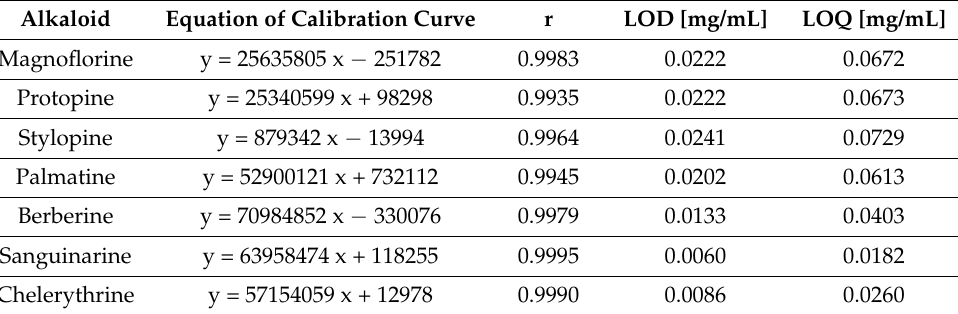
Table 3. Equation of calibration curve, correlation coefficients (r), limit of detection (LOD) and limit of quantification (LOQ) values. Alkaloid Equation of Calibration Curve r LOD [mg/mL] LOQ [mg/mL] Magnoflorine y = 25635805 x − 251782 0.9983 0.0222 Protopine y = 25340599 x + 98298 0.9935 0.0222 Stylopine y = 879342 x −